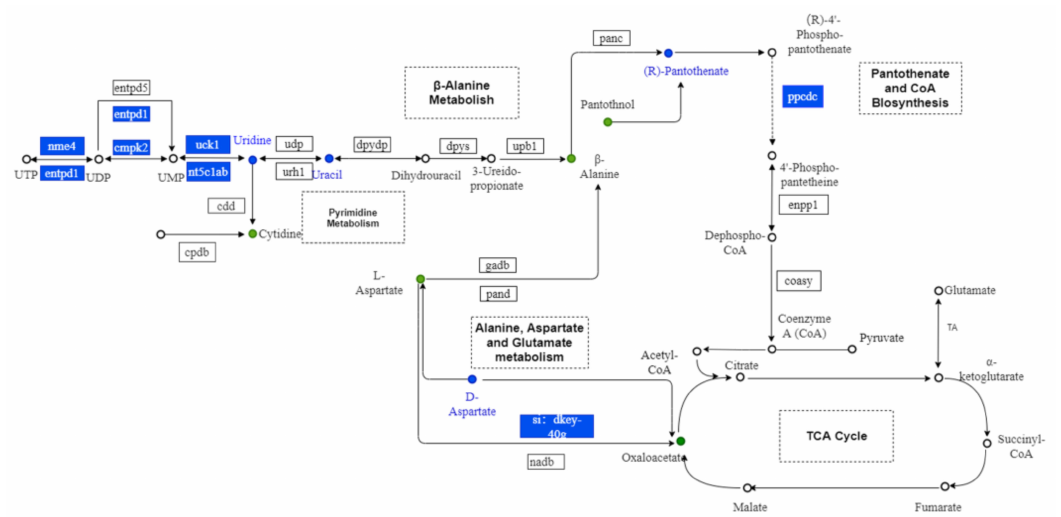
Figure 10. Metabolic maps of alanine, aspartate, and glutamate metabolism, pantothenate and CoA biosynthesis; pyrimidine metabolism; and β -alanine metabolism. Dots represent the metabolites. Boxes represent the genes. Blue indicates